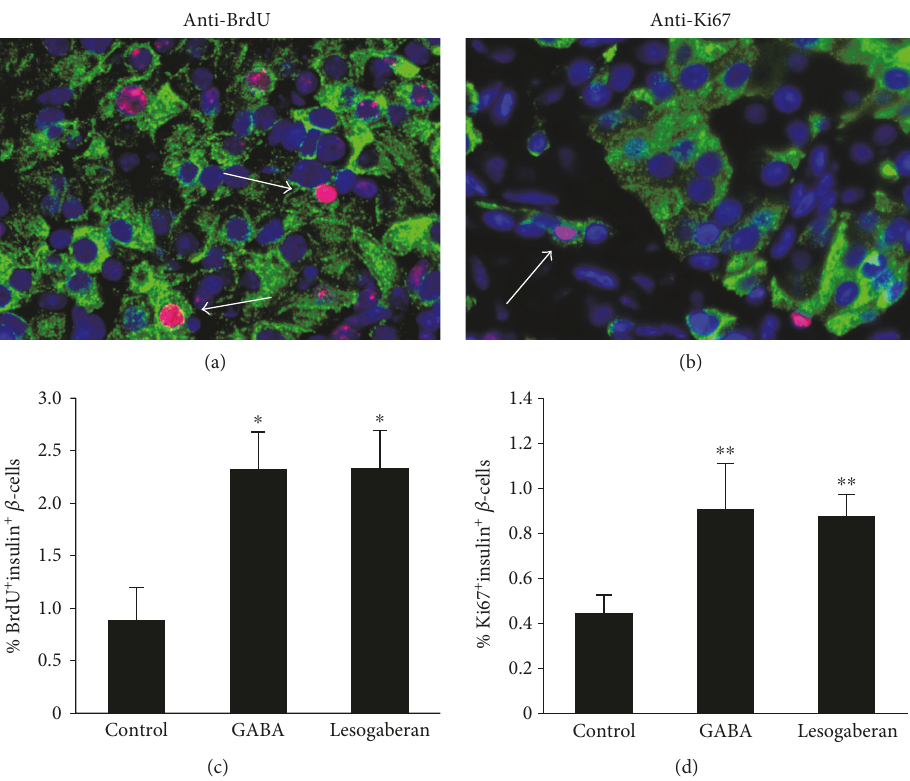
Figure 2: Oral lesogaberan promotes human islet β -cell replication in mice. Mildly hyperglycemic NOD/scid mice were transplanted with human islets under their kidney capsule. The mice were randomized and provided with water containing with BrdU, with or without GABA (6 mg/ml) or lesogaberan (0.08 mg/ml) for 12 days. The percentages of replicated β -cells were determined by immuno fl uorescent assays using anti-insulin and anti-BrdU or anti-Ki67, followed by counterstaining with DAPI. (a) Representative image of islet cells (magni fi cation × 400) costained with anti-insulin (green) and anti-BrdU (red) (arrows). (b) Representative image of islet cells costained with anti-insulin (green) and anti-Ki67 (red) (arrows). (c) Graphical representation of the percentages of BrdU + insulin + β -cells and (d) Ki67 + insulin + islet cells in total insulin + β -cells. Data are mean ± SEM from two independent experiments, each using islets from a human donor that were implanted into 4 – 9 NOD/scid mice. The percentages of BrdU + insulin + and Ki67 + insulin + β -cells in at least 2000 islet cells of 10 fi elds of each islet graft were determined as described in Materials and Methods. ∗ p < 0 05 , ∗∗ p < 0 01 versus the